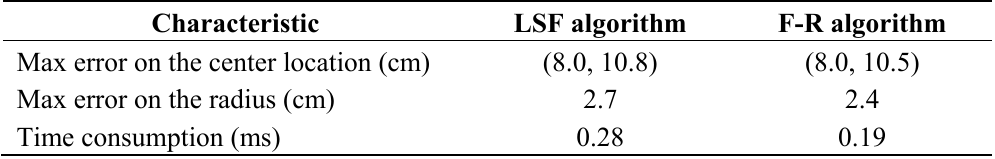
Table 2. The performance comparison of LSF algorithm and F-R